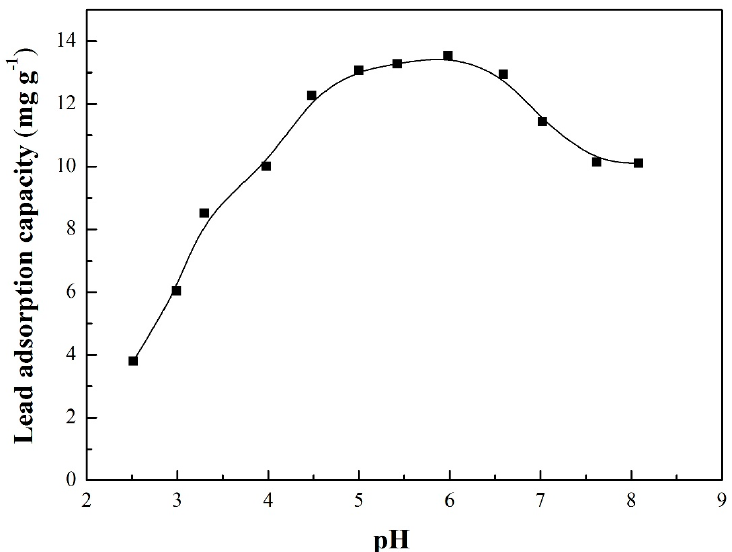
Figure 7. Adsorption capacity of lead ions on CSHW with respect to various pH values at an initial lead concentration of 30 mg L − 1 , balance time of 60 min, and operating temperature of 298 K.